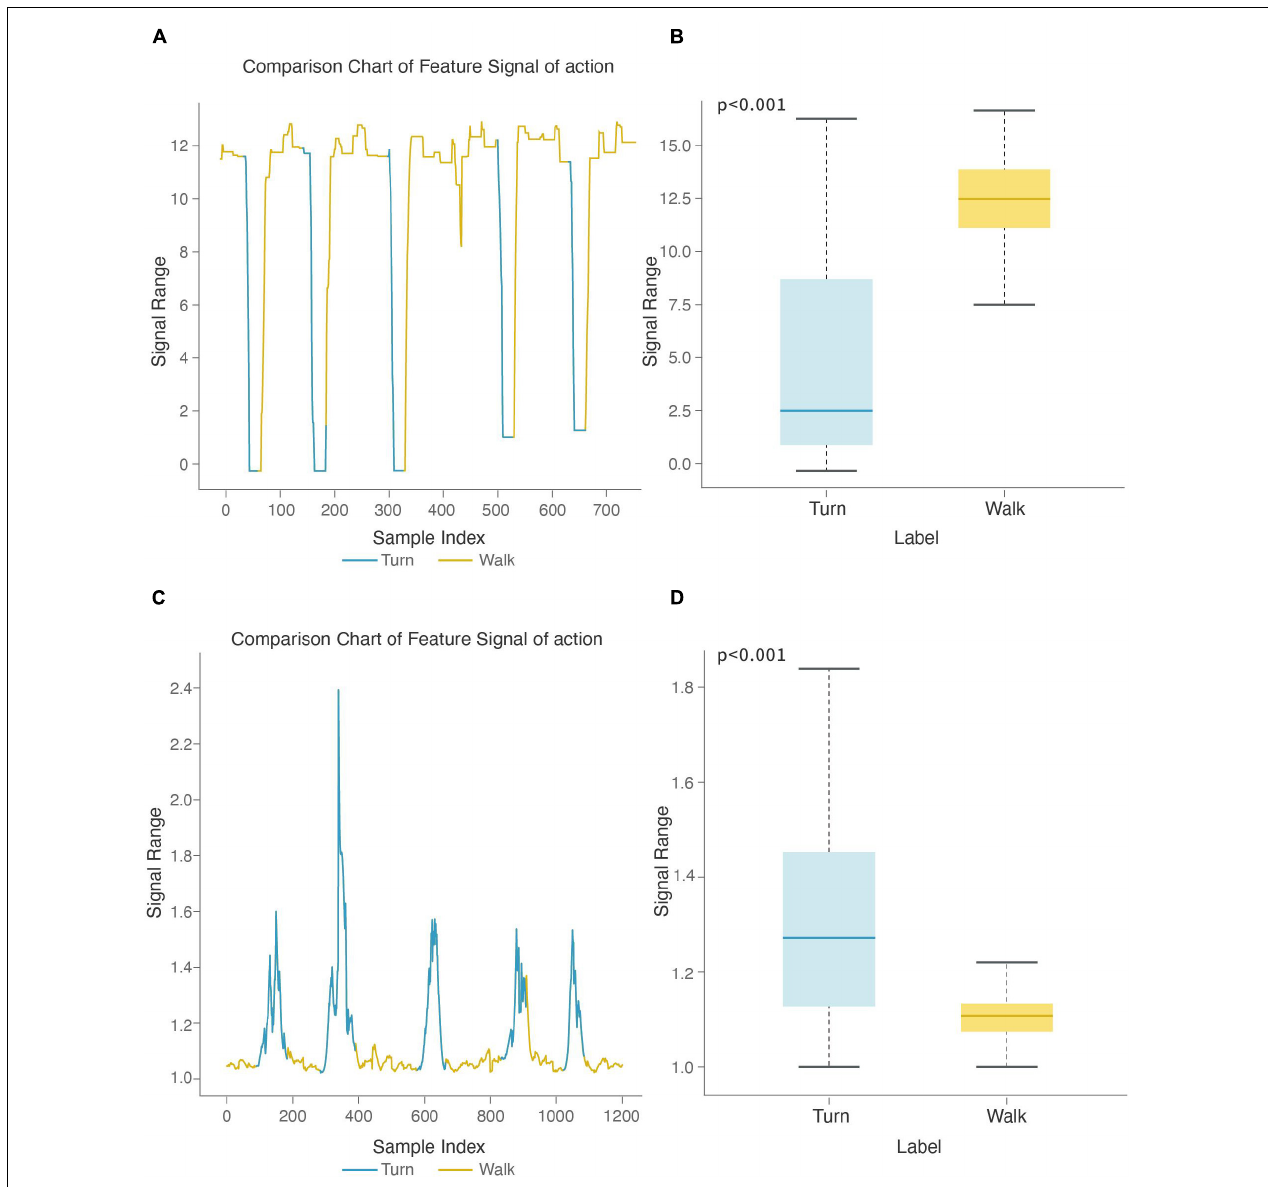
FIGURE 6 | Motion feature recognition boxplot and stage comparison chart analysis. (A) The stage comparison chart of the minimum value calculated by the absolute value signal of the position difference between the left and right shoulders. (B) Boxplot of the minimum value calculated by the absolute value signal of the position difference between the left and right shoulders. The feature was significantly different between the turning and walking groups ( p < 0.001). (C) Stage comparison chart of the crest factor calculated by the absolute value signal of the position difference between the right wrist and the left elbow. (D) Boxplot of the crest factor calculated by the absolute value signal of the position difference between the right wrist and the left elbow. The feature was significantly different between the turning and walking groups ( p < 0.001).